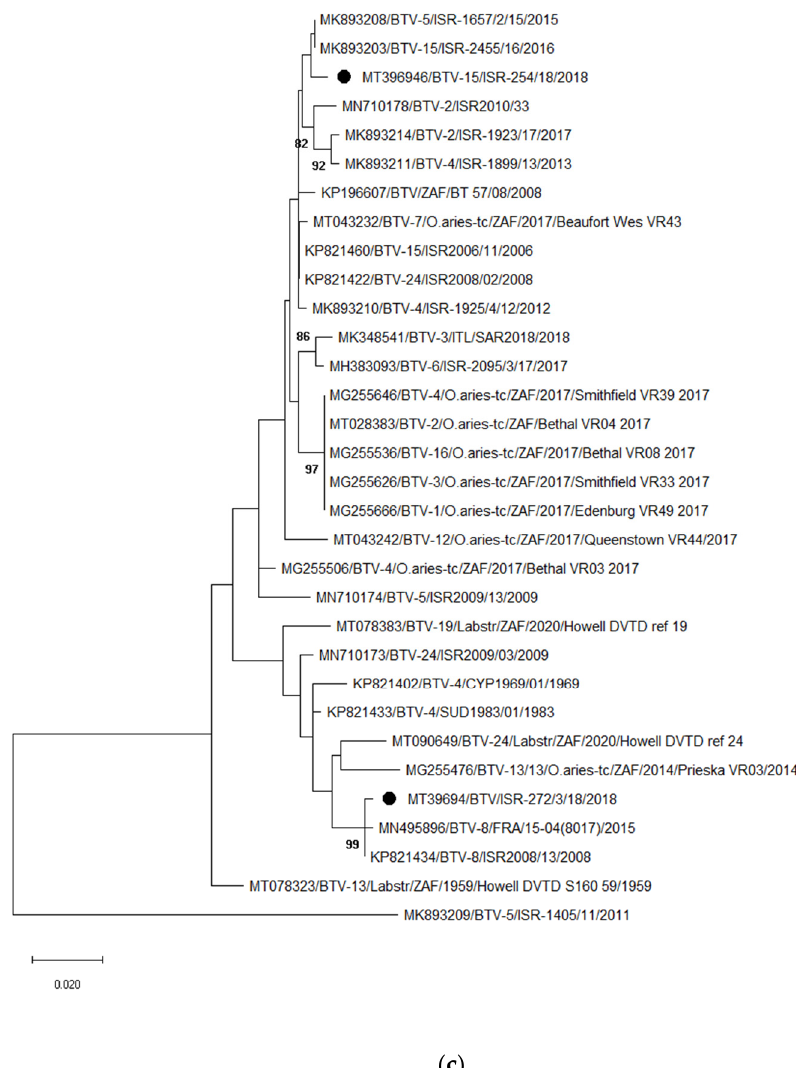
Figure 2. Phylogenetic analyses based on partial sequences of bluetongue viruses. ( a ) BTV-4, segment 2 (Seg-2); ( b ) BTV-3, Seg-2; ( c ) previous local (Israeli) strains and newly sequenced strains, Seg-5. The sequences obtained from NCBI GenBank are labelled by accession number/serotype/location/isolate/year (when all data is available in GenBank or the corresponding publications) and sequences generated in the present study are marked by black dots. Nucleotide sequences were analyzed using the Maximum Likelihood method and Tamura-Nei model. Statistical support for nodes was obtained by bootstrapping (1000 replicates); only values ≥ 70 % are shown. Scale bars indicate nucleotide substitutions per site.